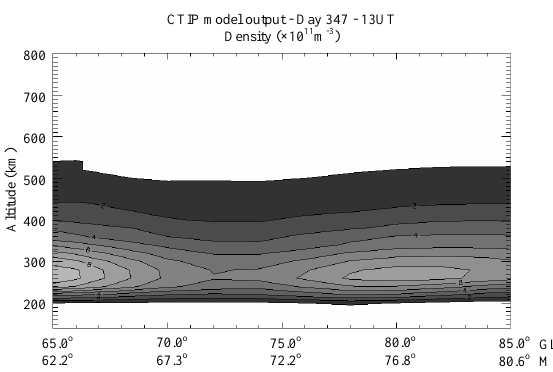
Fig. 5. Ionisation density distribution at 18 ◦ E and 13:00 UT from the CTIP model run with precipitation and convection input (M pc ) as a function of latitude and altitude.